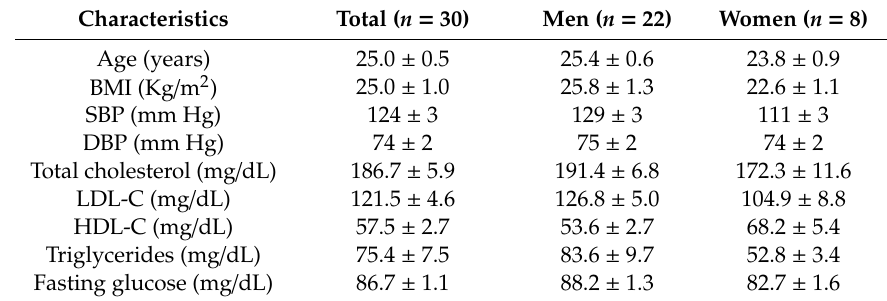
Table 1. Demographic, anthropometric and clinical characteristics of the participants by sex.